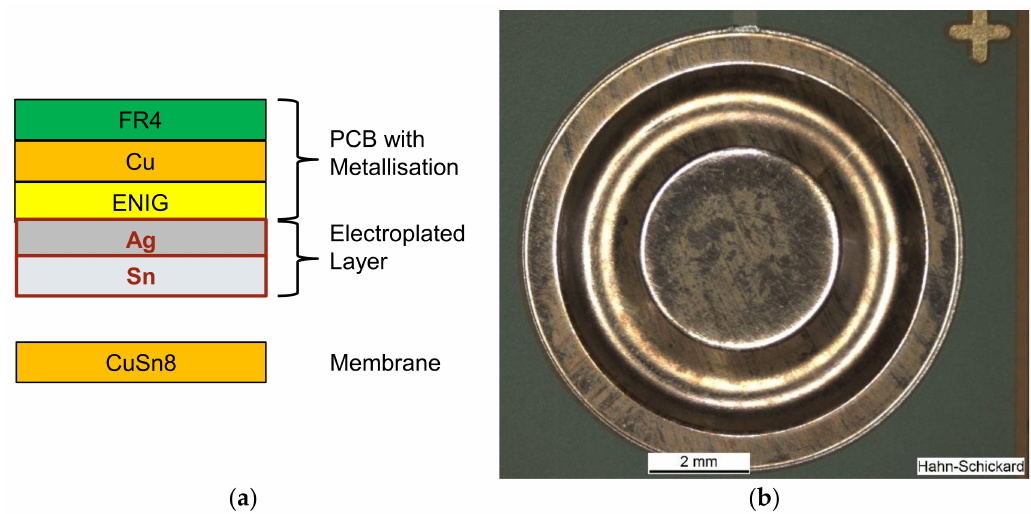
Figure 6. TLP bonding: ( a ) cross-section sketch of the layer structure; ( b ) top view of a TLP-bonded membrane.